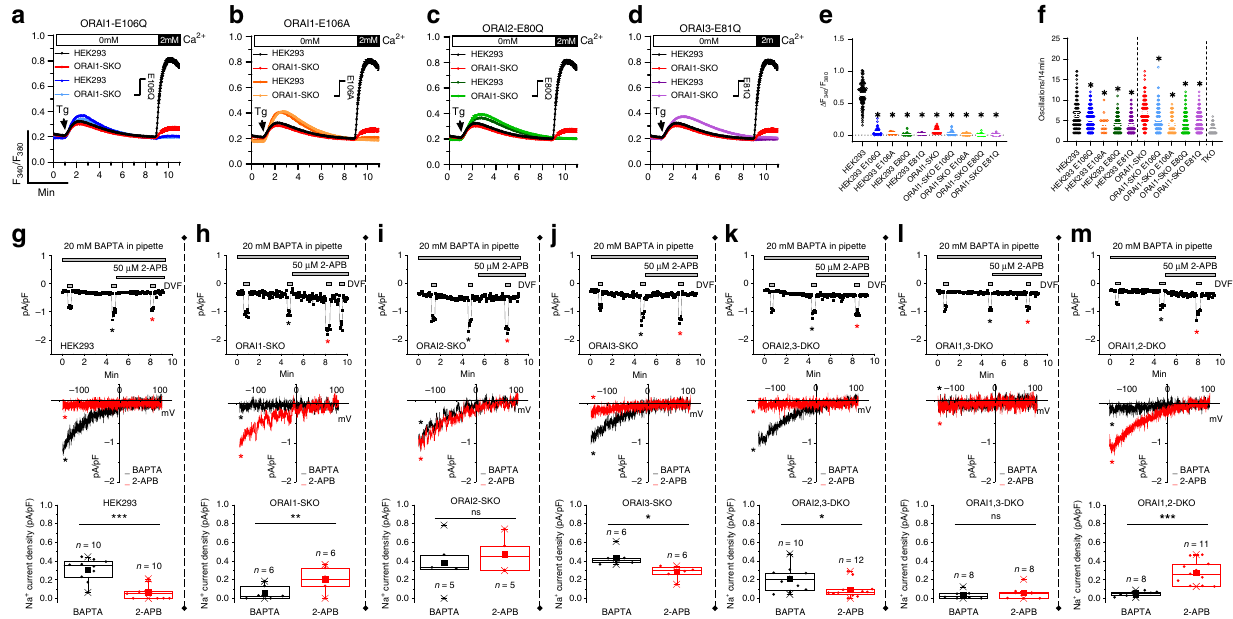
Fig. 5 Native CRAC channels are heteromultimers of ORAI isoforms. a – d Measurements of ER Ca 2 + release (in 0 mM Ca 2 + ) and SOCE (in 2 mM Ca 2 + ) on store depletion with 2 µ M thapsigargin (Tg) in HEK293 cells and ORAI1 single-knockout (ORAI1-SKO) cells either untransfected or transfected with ORAI pore mutants: ORAI1-E106Q ( a ), ORAI1-E106A ( b ), ORAI2-E80Q ( c ), and ORAI3-E81Q ( d ). e Quanti fi cation of SOCE magnitude for a – d ) (left to right n = 130, 76, 68, 64, 53, 116, 53, 57, 51, and 37; points represent individual cells). f Quanti fi cation of oscillations/14 min for a – d ; data from ORAI-TKO cells (Fig. 1f) is included as a reference (left to right n = 97, 142, 175, 124, 119, 119, 127, 145, 19, 70, and 84; points represent individual cells). Data are represented as mean ± SEM and were statistically analyzed using the Kruskal – Wallis one-way ANOVA with multiple comparisons (* p < 0.05). Comparisons in e were made to WT HEK293. Comparisons in f were made to the corresponding untransfected control (i.e., WT HEK293 or ORAI1-SKO). g – m CRAC current measurements on store depletion by dialysis of 20 mM 1,2-bis(o-aminophenoxy)ethane-N,N,N ′ ,N ′ -tetraacetic acid (BAPTA) through the pipette followed by perfusion of 50 µ M 2-APB in the bath. Native CRAC current recordings were performed in HEK293 cells ( g ), ORAI1-SKO cells ( h ), ORAI2-SKO cells ( i ), ORAI3-SKO cells ( j ), ORAI2,3-DKO cells ( k ), ORAI1,3-DKO cells ( l ), and ORAI1,2-DKO cells ( m ). Top panels: representative current traces elicited by voltage ramps from − 140 mV to + 100 mV from a holding potential of + 30 mV with three pulses of divalent-free solutions to amplify native CRAC currents. The fi rst pulse is performed immediately after whole-cell con fi guration, the second pulse after CRAC current has been maximally activated (4 – 5 min after break-in) and the third pulse after 2-APB perfusion (~8 min after break-in). (middle panels) representative I / V curves for maximal CRAC current (black trace) and after 2-APB addition (red trace) taken where indicated in top panels by the color-coded asterisks. (lower panels) statistical analysis of peak background-subtracted Na + CRAC current densities (represented as mean ± SEM) recorded from several cells in DVF solutions before and after 2-APB perfusion. Data were statistically analyzed using a two-tailed Student ’ s t -test (* p < 0.05; ** p < 0.01; *** p < 0.001; ns, not signi fi cant). Boxplots show the mean, median, and the 75th to 25th